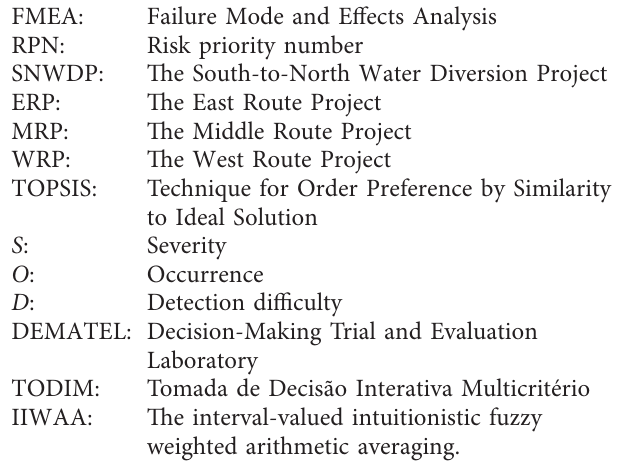
The interval-valued intuitionistic fuzzy weighted arithmetic